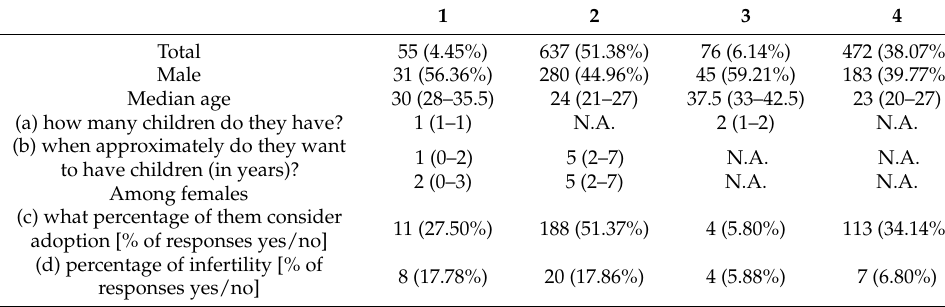
Table 2. The basic characteristic of groups.